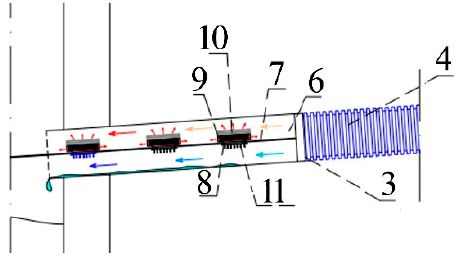
Energies 2021 , 14 , x FOR PEER REVIEW Figure 2. Application of Peltier cells inside the pipe. Figure 2. Application of Peltier cells inside the pipe. Figure 2. Application of Peltier cells inside the pipe.